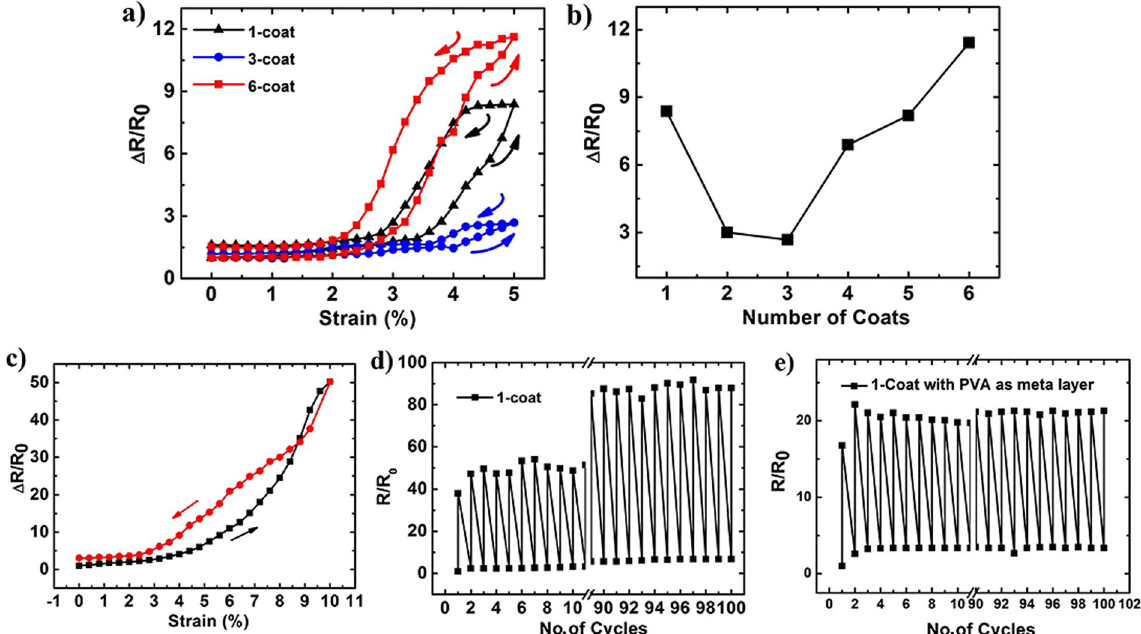
Figure 4. ( a ) Fractional change in resistance vs. strain for 1-coat, 3-coat and 6-coat films. ( b ) Resistance change of rGO films at 5% strain normalized to the resistance at 0% strain value vs. number of coats. ( c ) Strain response of 1-coat sample for up to 10% strain. Resistance vs. strain behavior of 1-coat sample up to 10% strain under cyclic loading test (100 cycles): ( d ) without meta-layer; ( e ) with PVA